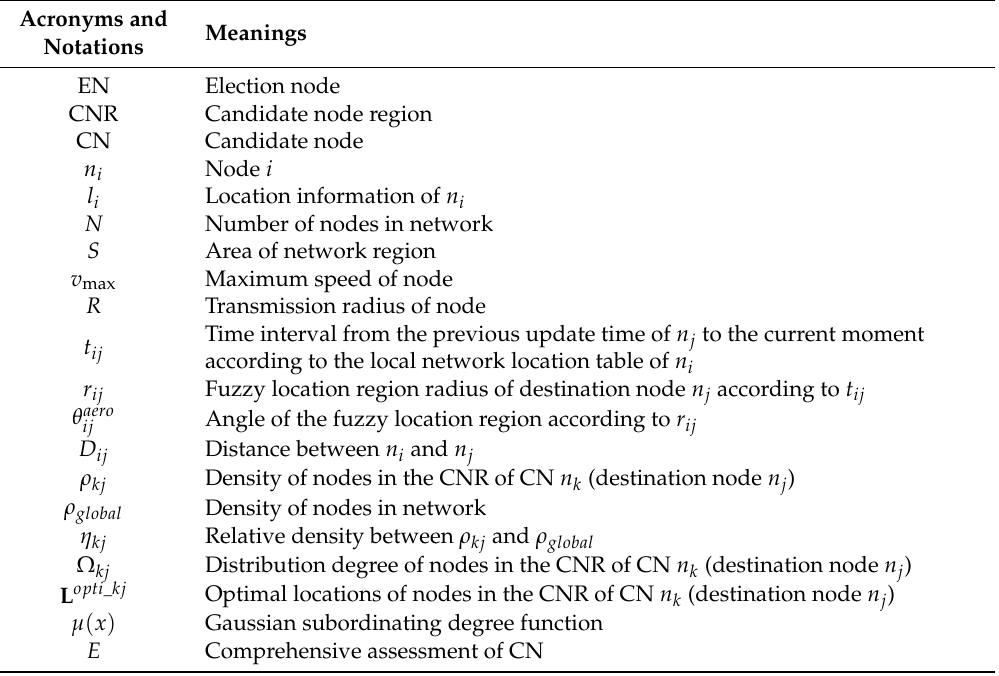
Table 1. Detailed list of acronyms and notations.